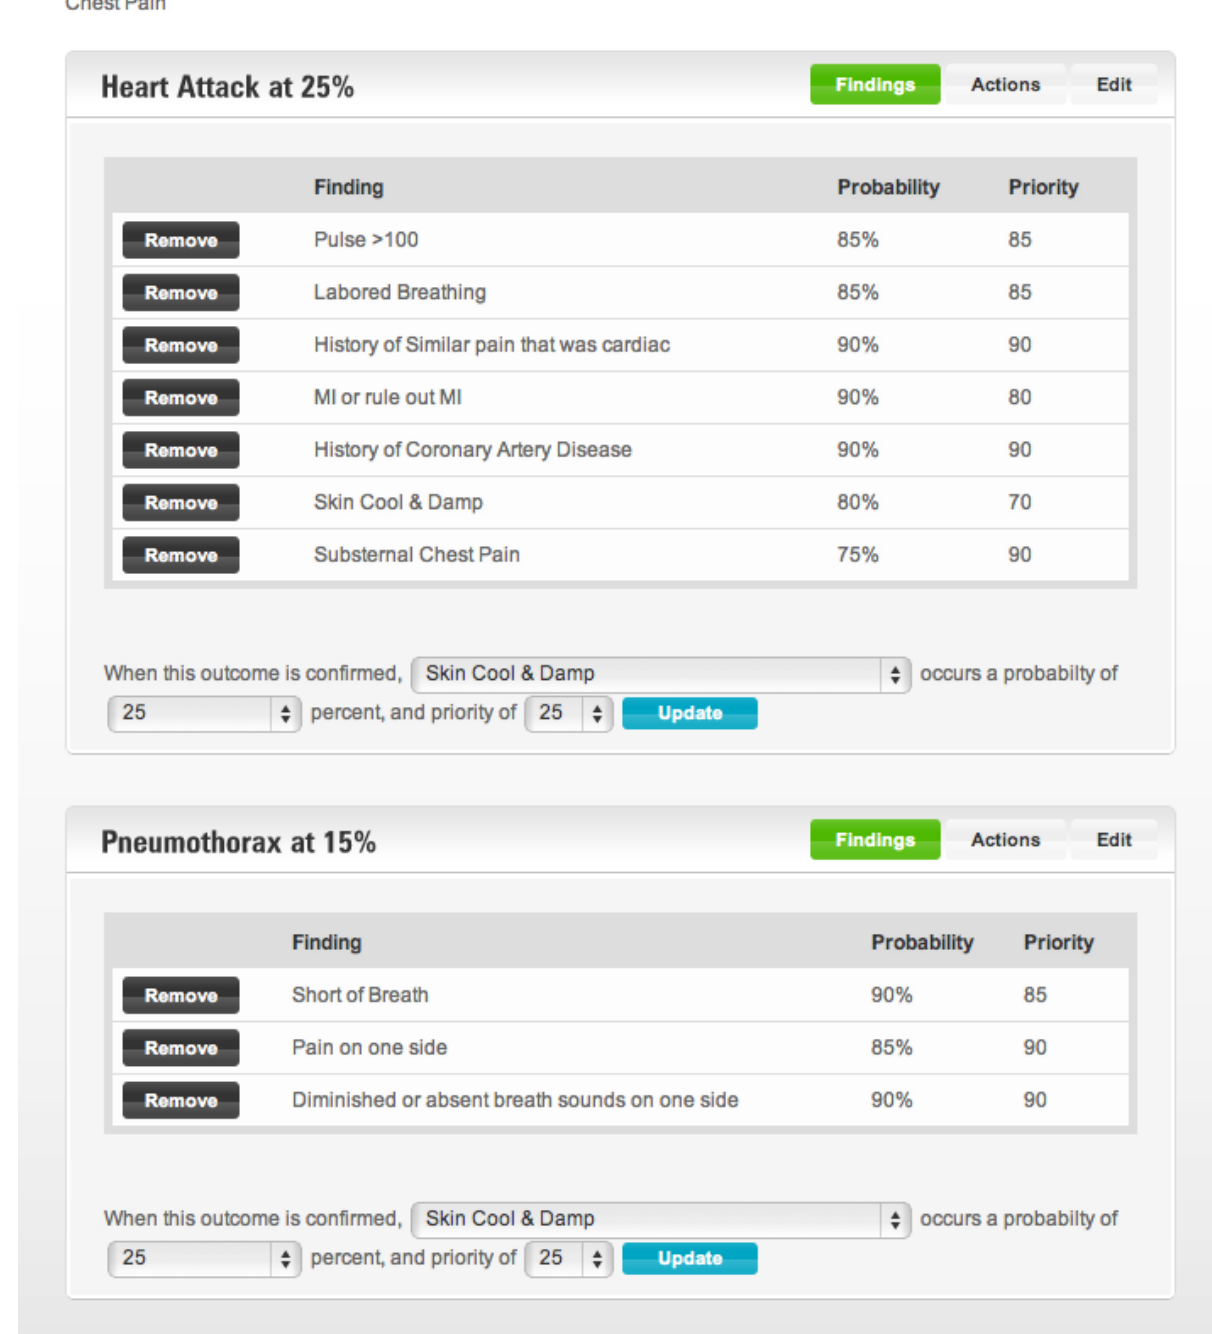
Figure 3. The clinical rule editor in the Web-based